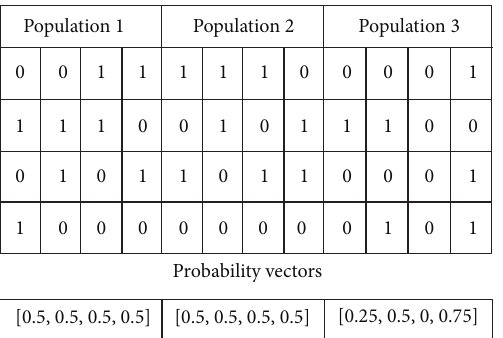
Figure 1: Probability vectors and their corresponding populations.